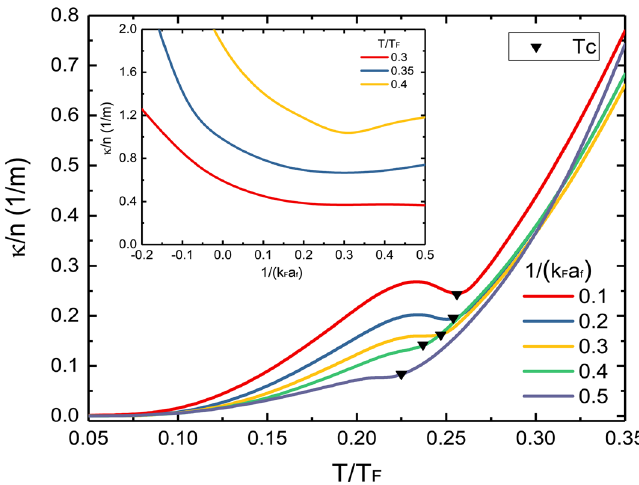
Figure 3. κ versus T / T F for different ν at the BEC side. The triangles mark κ( T c ) . Here T ∗ on each of these curves is higher than the temperature range shown. Inset: κ versus ν for different T / T F